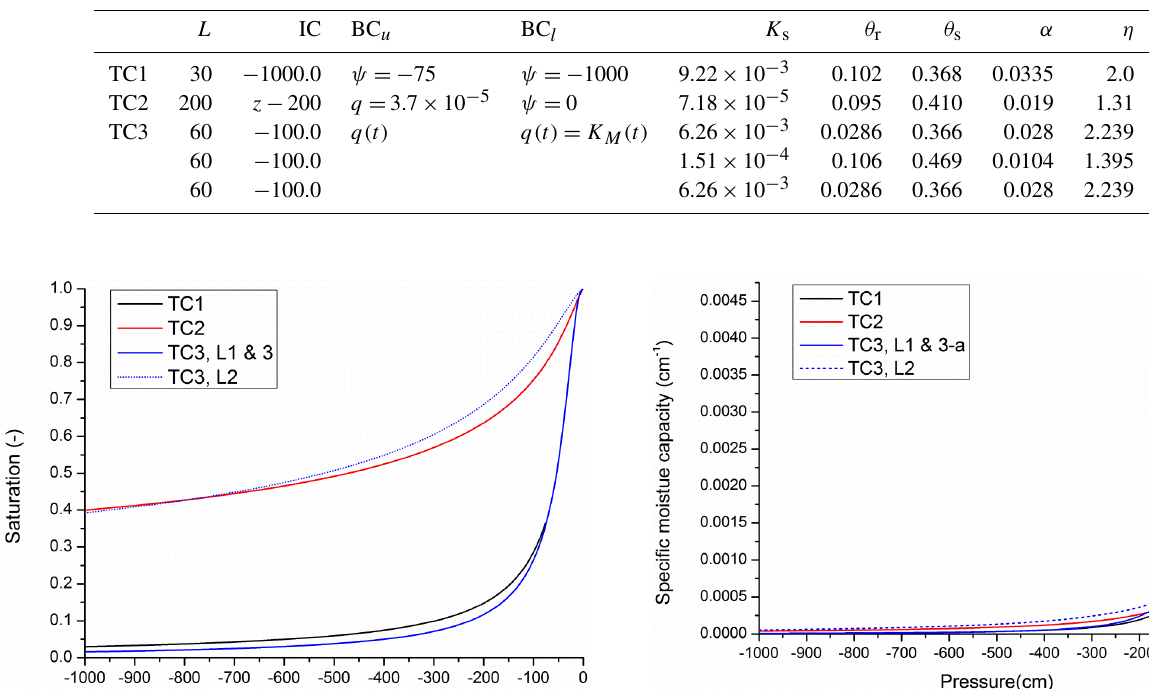
Table 2. Domain size ( L ), initial conditions (IC), boundary conditions at the soil surface (BC u ) and at the soil bottom (BC l ) , saturated hydraulic conductivity ( K s ) , residual and saturated water contents ( θ r , θ s ) and shape parameters ( α , η) for the different test cases. K M (t) is the hydraulic conductivity of the last grid cell. Length and time units are centimeters and seconds, respectively.